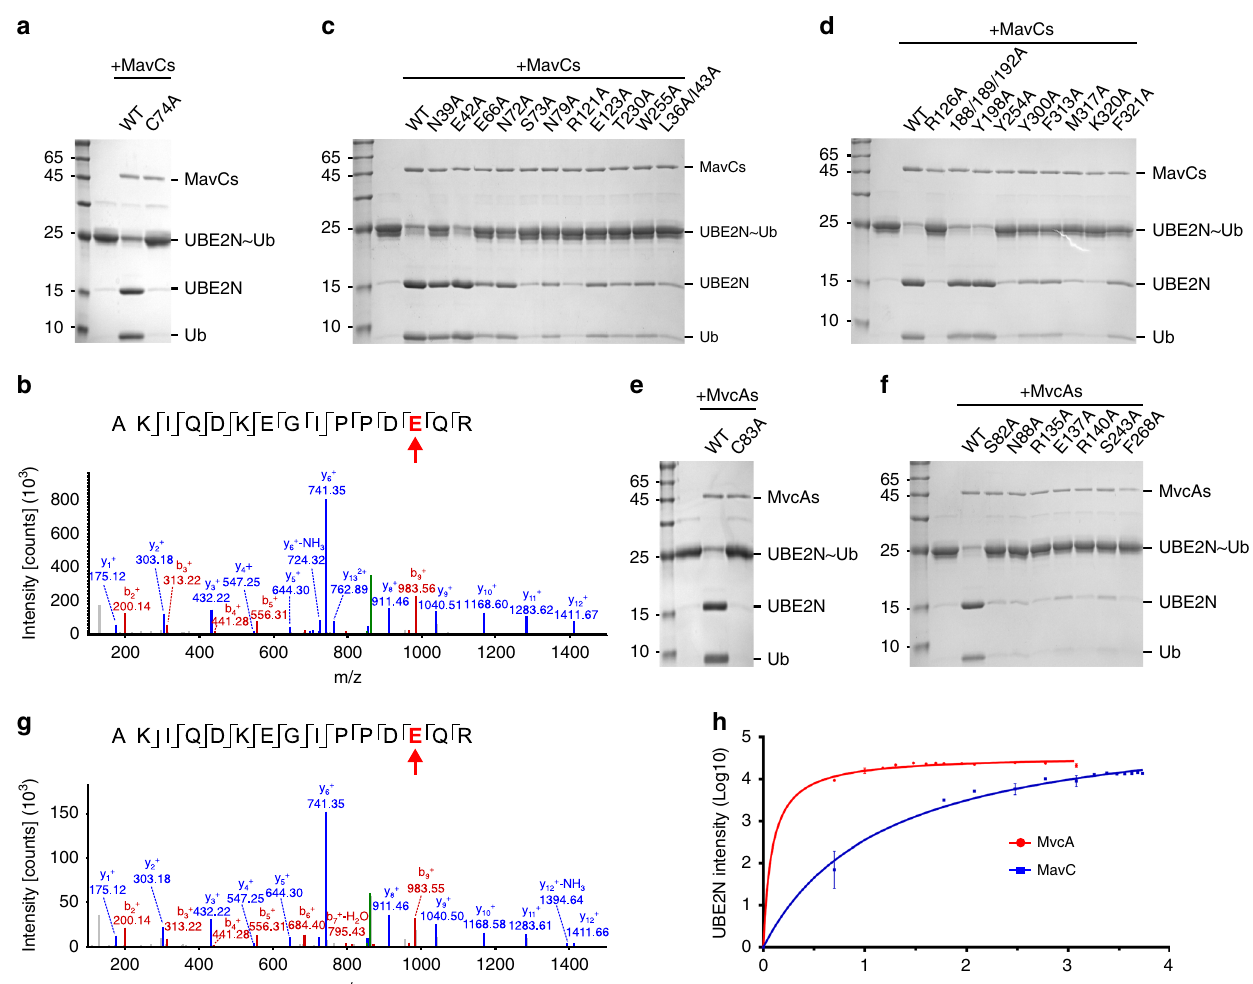
Fig. 4 MavC and MvcA can remove MavC-mediated ubiquitination. a The conjugated UBE2N~Ub can be cleaved by WT MavC, but not MavC C74A . b Mass spectrometry analysis of the protein band corresponding to Ub catalyzed by WT MavC from panel a . The Ub product is the deamidated form (E40). c , d Indicated MavC proteins were incubated with the conjugated UBE2N~Ub. The reaction mixtures were subjected to SDS-PAGE and stained with Coomassie dye. e The conjugated UBE2N~Ub can be cleaved by WT MvcA, but not MvcA C83A . f Indicated MvcA proteins were incubated with the conjugated UBE2N~Ub. The reaction mixtures were subjected to SDS-PAGE and stained with Coomassie dye. g Mass spectrometry analysis of the protein band corresponding to Ub catalyzed by WT MvcA from panel e . The Ub product is the deamidated form (E40). h The conjugated UBE2N~Ub was treated with same amounts of MavC and MvcA. The intensities of released UBE2N bands were measured in different time points (shown in Supplementary Fig. 4d, e). Each experiment was done in duplicate, and the data were analyzed using GraphPad Prism software. The error bars represent mean ± SEM. Source data are provided as a Source Data fi le. Experiments in a , c – f were repeated independently three times with similar Molecular basis of inhibition for MavC and MvcA by Lpg2149 .